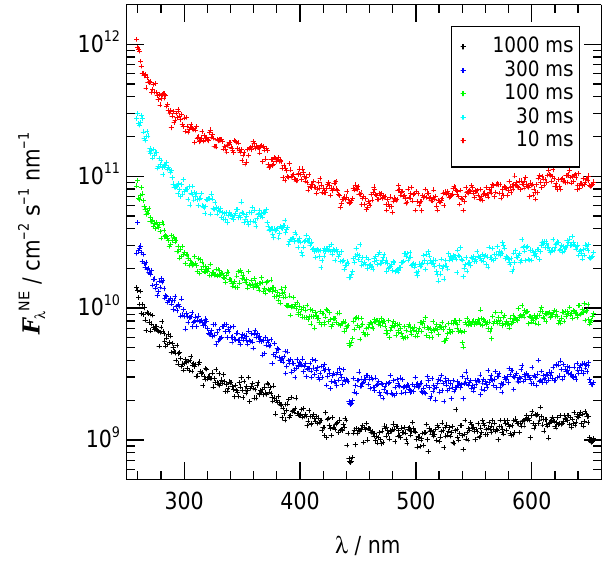
of Figure 12. Contour plot of atmospheric cutoff wavelengths (nm) for λ, dark an altitude of 15km as a function of the solar zenith angle (SZA) and total ozone column (TOC). The data were derived from radia- tive transfer calculations of downward clear-sky spectral actinic flux densities defining a lower limit F λ ≤ 5 × 10 9 cm − 2 s − 1 nm − 1 . A similar plot for an altitude of 0km can be found in the